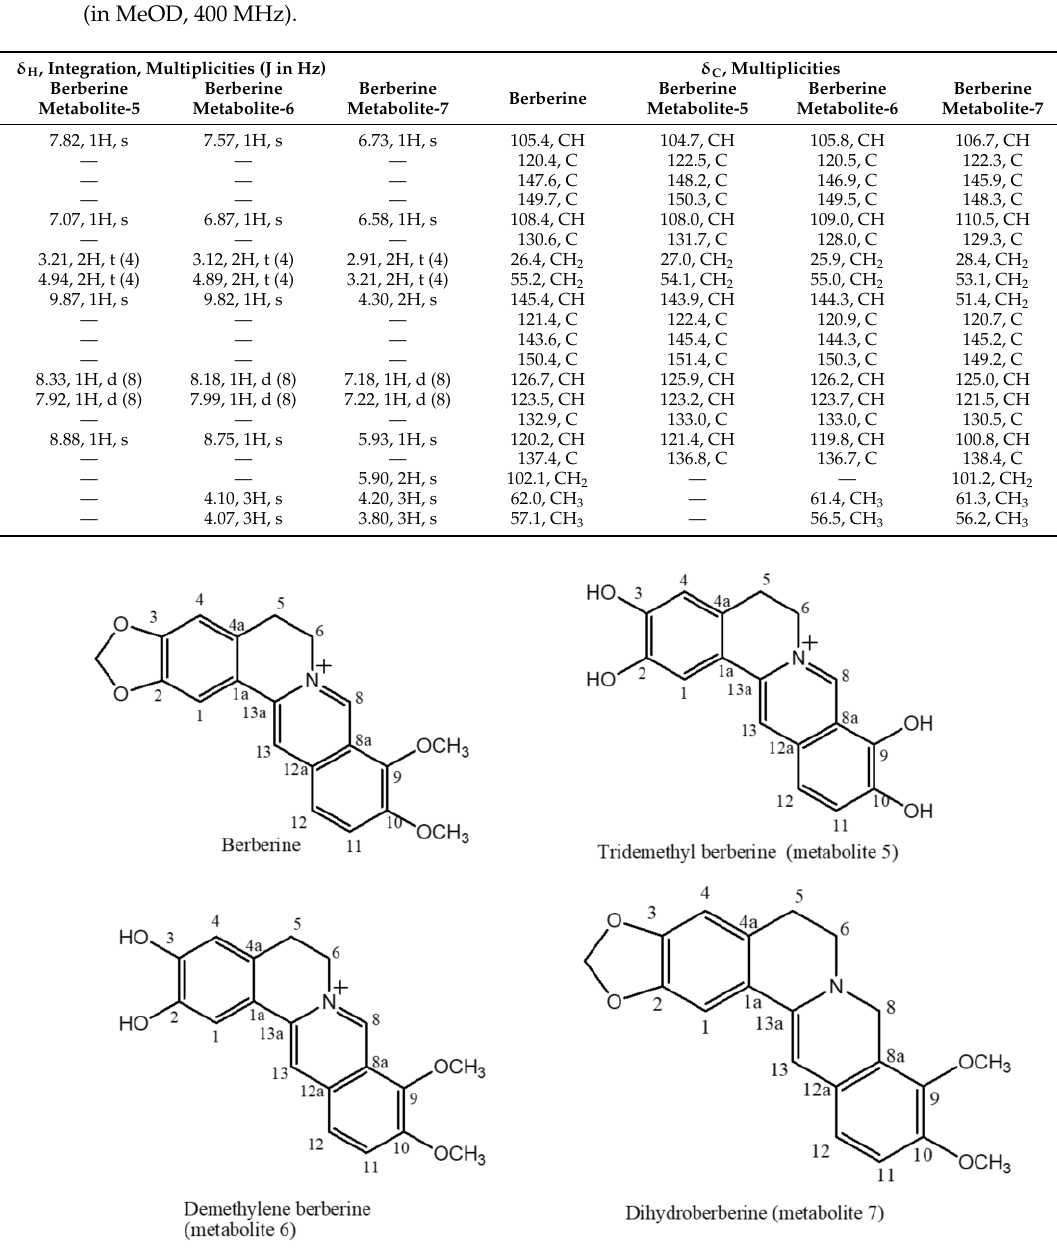
Figure 2. Structure of berberine and its metabolites. The 1 H NMR data of the berberine metabolite- 7 compared to that reported about berberine [25] (Table 2, SI: Figure S37) displayed a lack of a singlet signal of one proton intensity of H-8 at δ H 9.77 present in berberine and appearance of a new singlet signal of two proton at δ H 4.30 ppm which can be ascribed to a reduction reaction of bond between C-8 and the nitrogen atom. The 13 C NMR of 7 (Table 2, SI: Figure S38) showed 20 peaks corresponding to 20 different carbon atoms which is the same number of carbon signals present in berberine. There is a significant shielding of C-8 signal (by 94 ppm) due